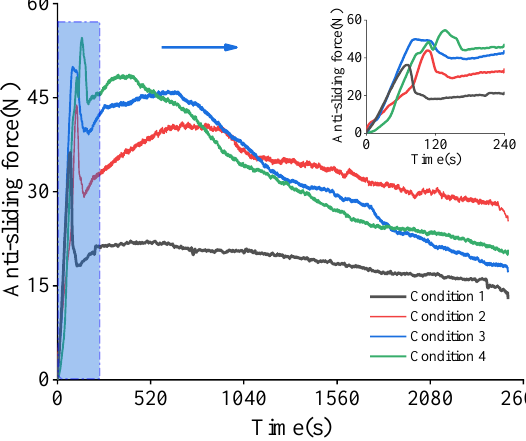
Figure 8. Anti-sliding force curve of the four conditions.